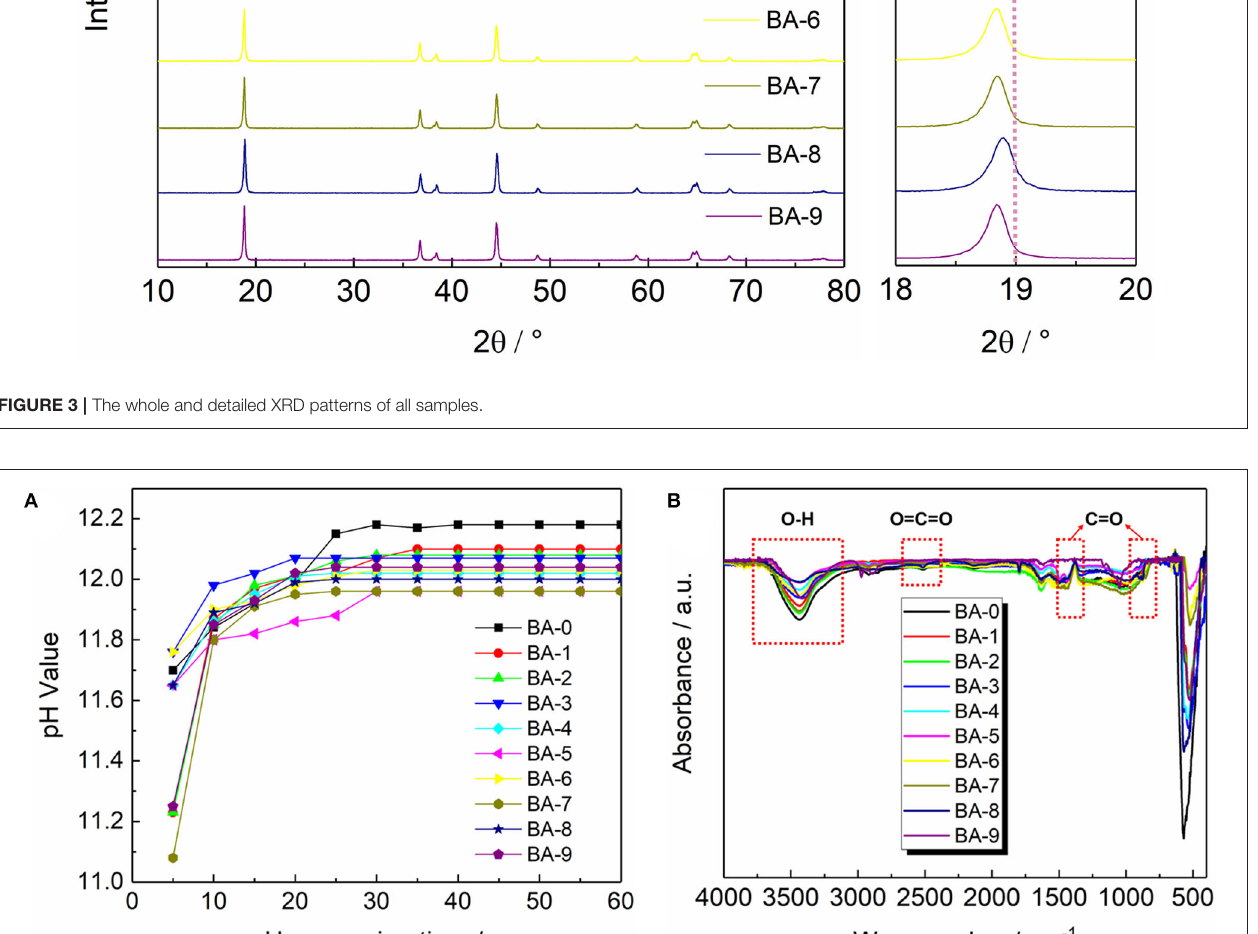
I (003) / I (104) values in Table S1 also exhibit that some of the modified materials suffer more severe cation mixing than BA-0, conflicting with the conclusions in Figure S2 . Therefore, we put forward a hypothesis that weak acid such as BA has